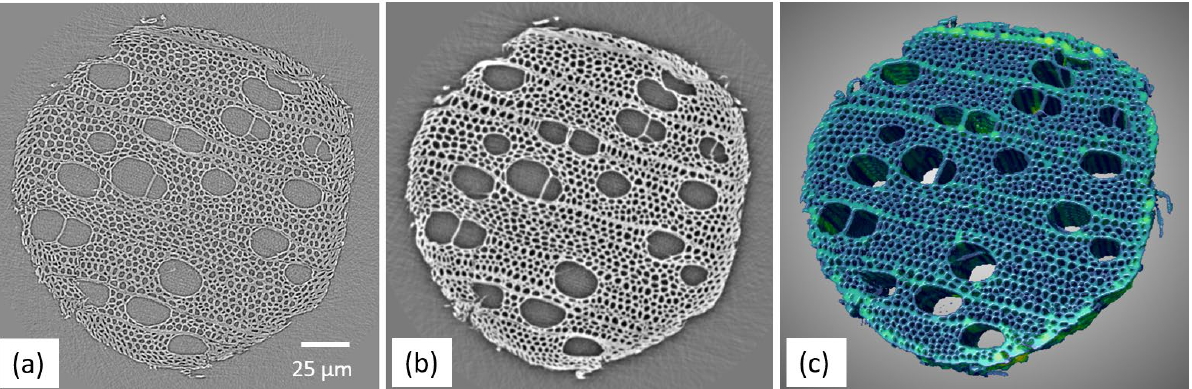
Figure 8. Slice reconstruction of wood structure (toothpick) without TIE-Hom phase-retrieval in ( a ) and with TIE-Hom phase-retrieval in ( b ), with the 3D visualization of the data such as in ( b ) presented in ( c ). Data were collected using white beam, 20× objective lens, exposure time of 0.7 s, and sample-detector distance of 160 mm.